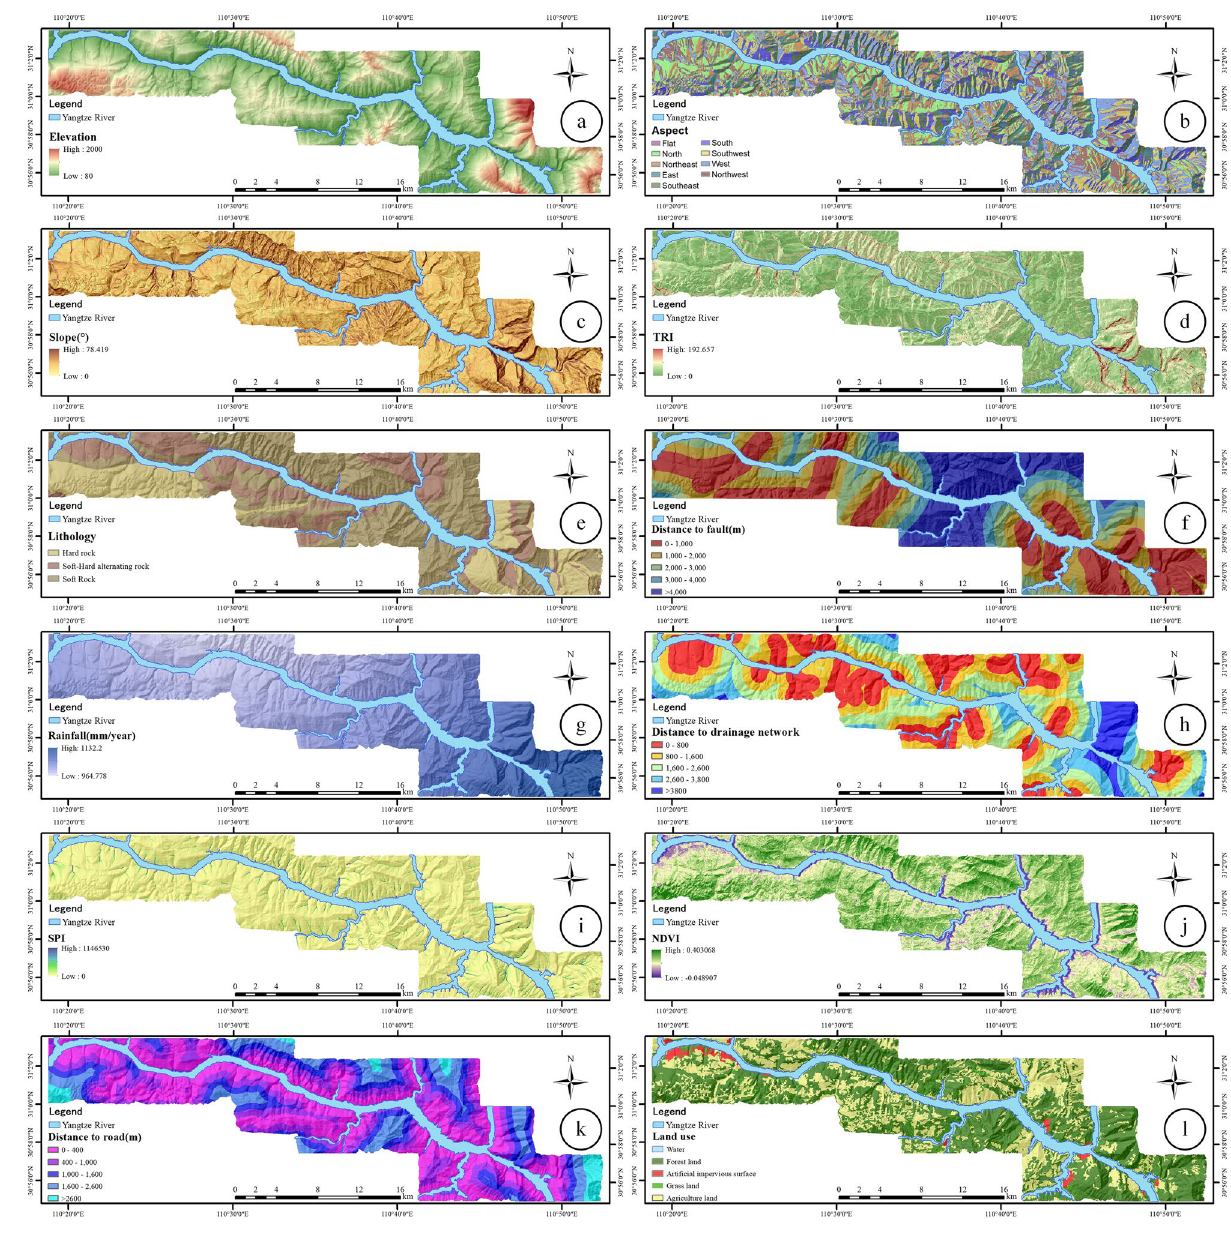
Figure 6. LSM factors in the study area ( a ) Elevation factor, ( b ) Aspect factor, ( c ) Slope factor, ( d ) TRI factor, ( e ) Lithology factor, ( f ) Distance to fault factor, ( g ) Rainfall factor, ( h ) Distance to drainage network factor, ( i ) SPI factor, ( j ) NDVI factor, ( k ) Distance to road factor, ( l ) Land use factor (drawn with ArcGIS 10.8 software, and the URL is: https:// www. esri. com/ en- us/ arcgis/ about- arcgis/ overv